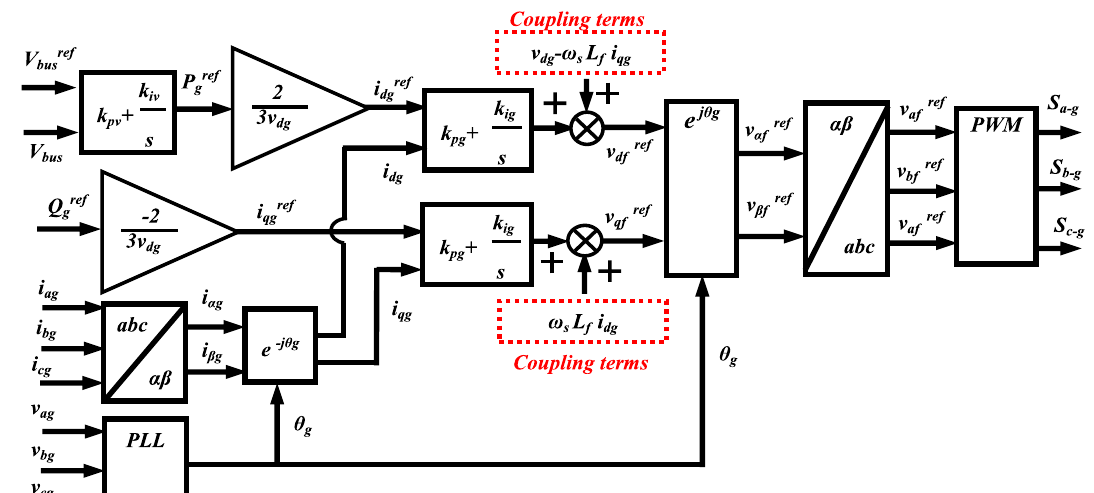
Fig. 11 Vector control of the GSC using the PI controller